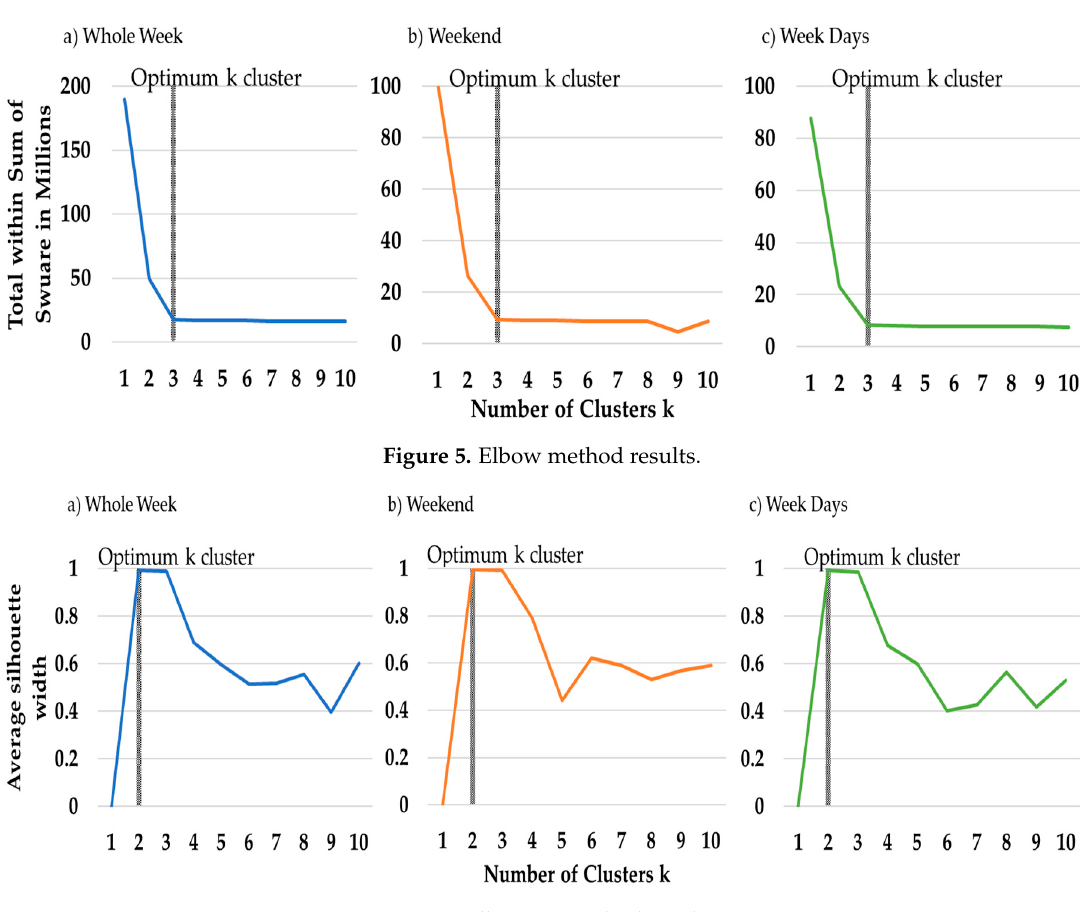
Figure 6. Silhouette method results.